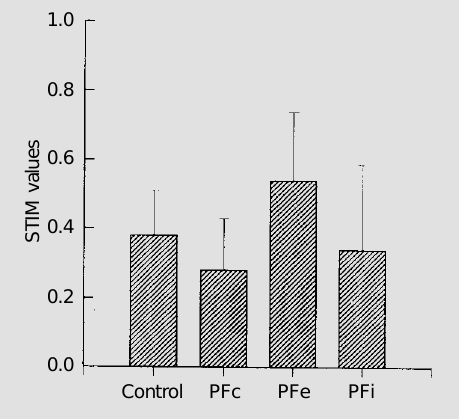
Figure 4 - Stimulation of acro- some reaction in response to neoglycoprotein. The STIM val- ues were calculated as de- scribed in Material and Methods. Results are reported as the mean ± SEM of 12 sperm samples. There were no stastis- tical